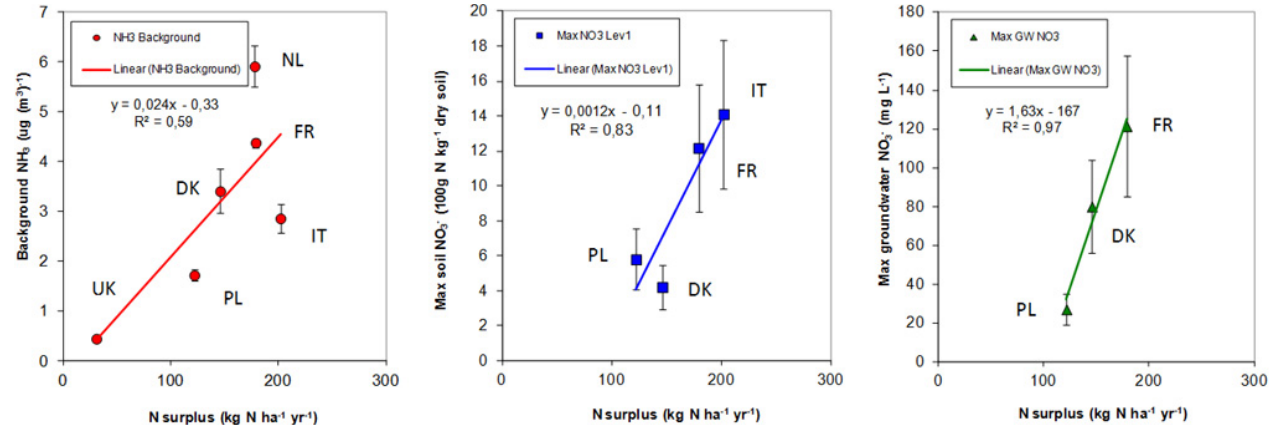
Fig. 5. Comparison of average landscape N surpluses with measured ammonia concentrations (lowest site-mean, left) and soil nitrate levels (maximum nitrate concentration measured in the A-horizon of any site, centre) and groundwater nitrate levels (maximum nitrate concentra- tion measured at any site, right). Measurement uncertainty for ammonia was calculated from the standard errors of the individual monthly concentrations and for nitrate from the mean uncertainty for the concentration values where uncertainty was reported ( ± 30% for both soil and